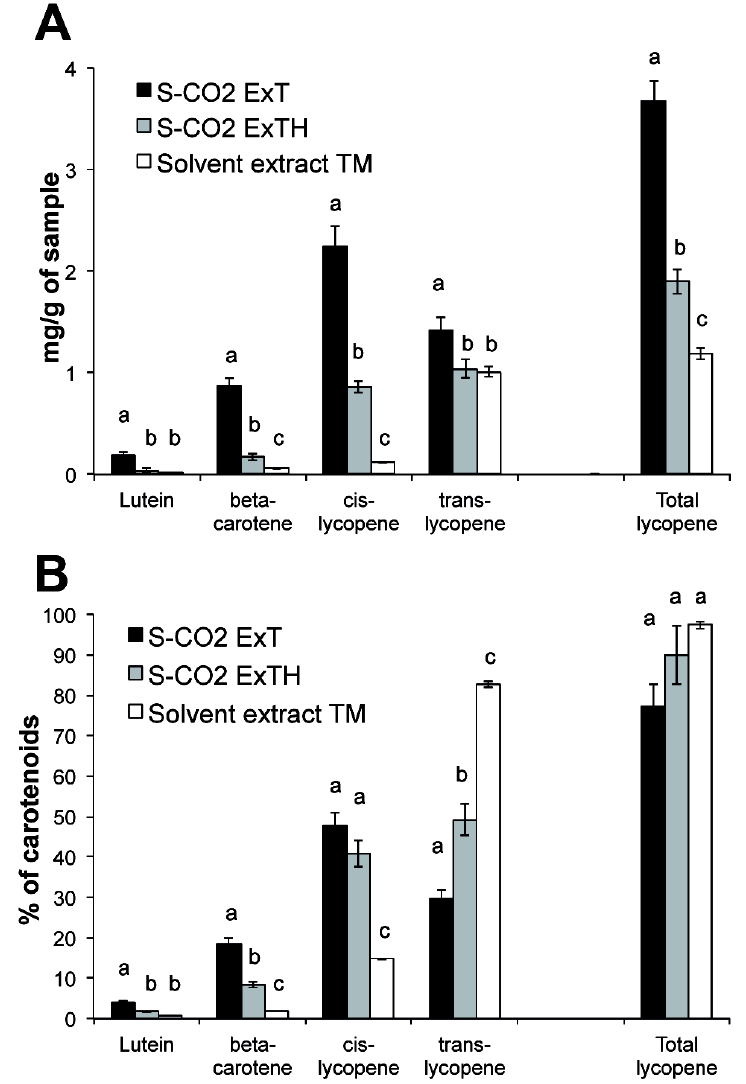
Figure 2. Carotenoid composition. Carotenoids and total lycopene content, expressed as mg per gram of oleoresin or tomato powder ( A ) or as percentage of the total carotenoids ( B ), in tomato powder extracted by hexane (Solvent extract), in the S-CO tomato powder (S-CO ExT) and from tomato powder added with hazelnut powder 2 (S-CO ExTH). Data are mean ± SD of three measures from three independent 2